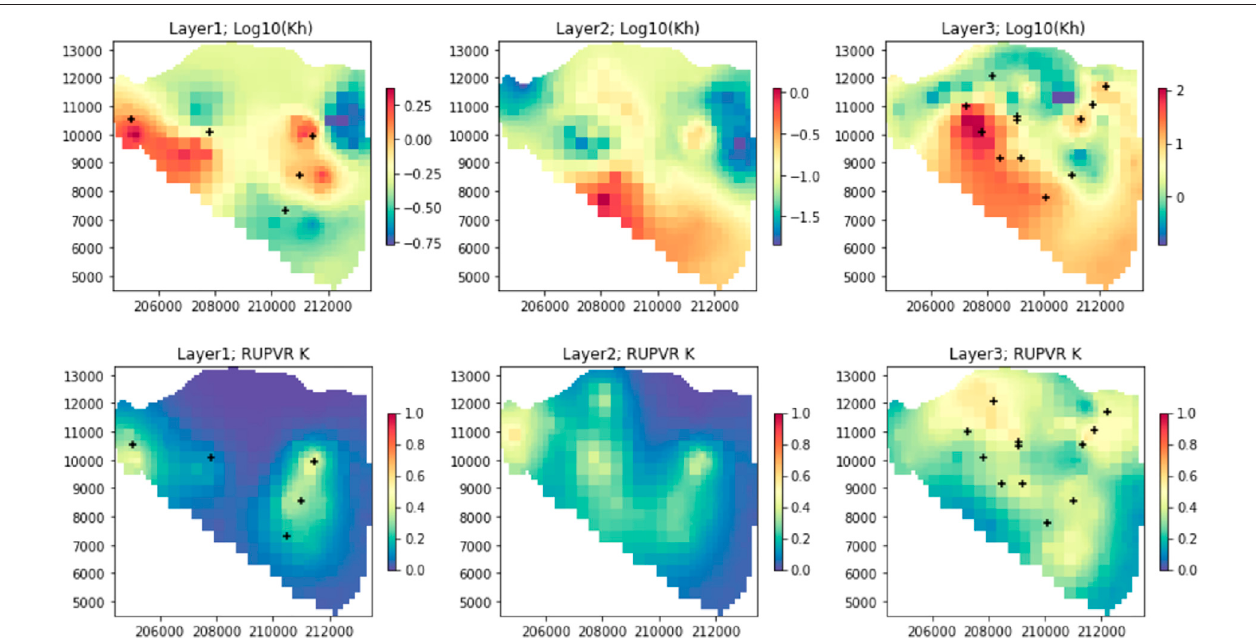
FIGURE 9 | Spatial distribution of (log) hydraulic conductivity in layers 1 (phreatic), 2 (aquitard) and 3 (semi-con fi ned) (top, left to right), and RPUVR of hydraulic conductivity in layers 1, 2 and 3 (bottom, left to right), location of hydraulic head observations for each layer indicated by black crosses.